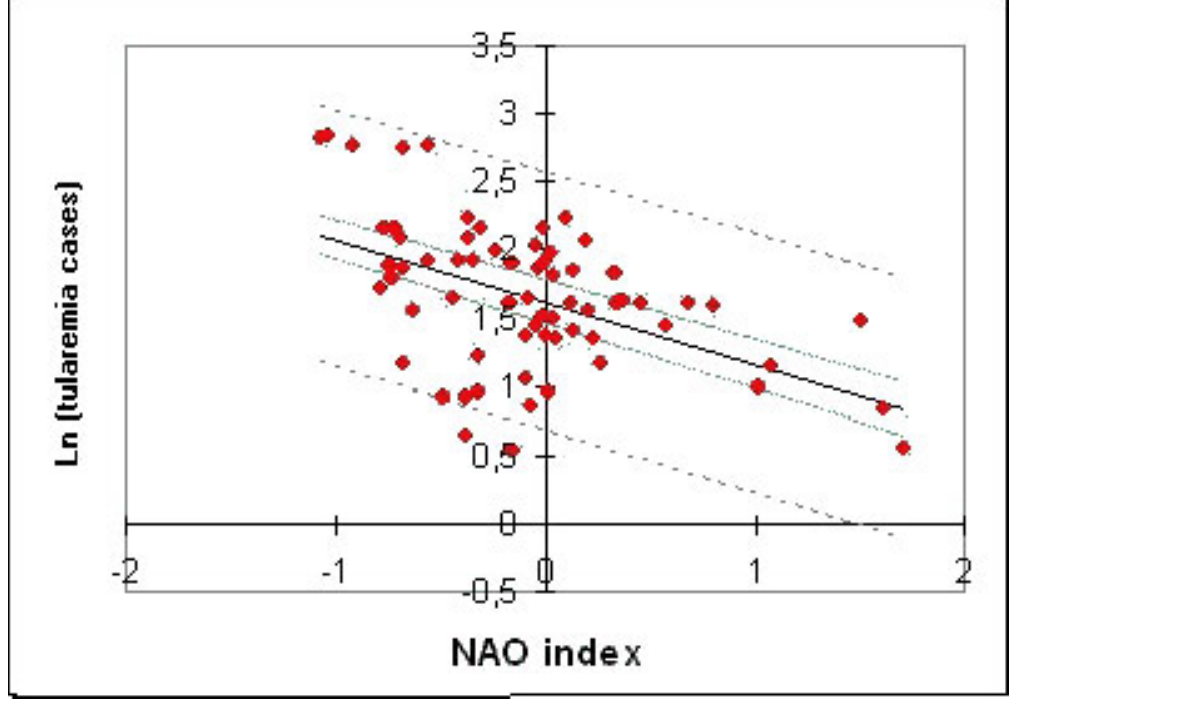
Fig. 2. Tularemia and the North Atlantic Oscillation (NAO) index. Five-year smoothed mean of the winter NAO index and log number of human tularemia cases in Sweden for the years 1931–2002. Linear regression equation: Y = 1.617 - 0.458 x ( r 2 = 0.25, F = 21.63, p < 0.001). Red dots represent observations, solid black lines represent predictions, dotted lines show a 95% confidence limit for predictions, and solid gray lines show a 95% limit for the